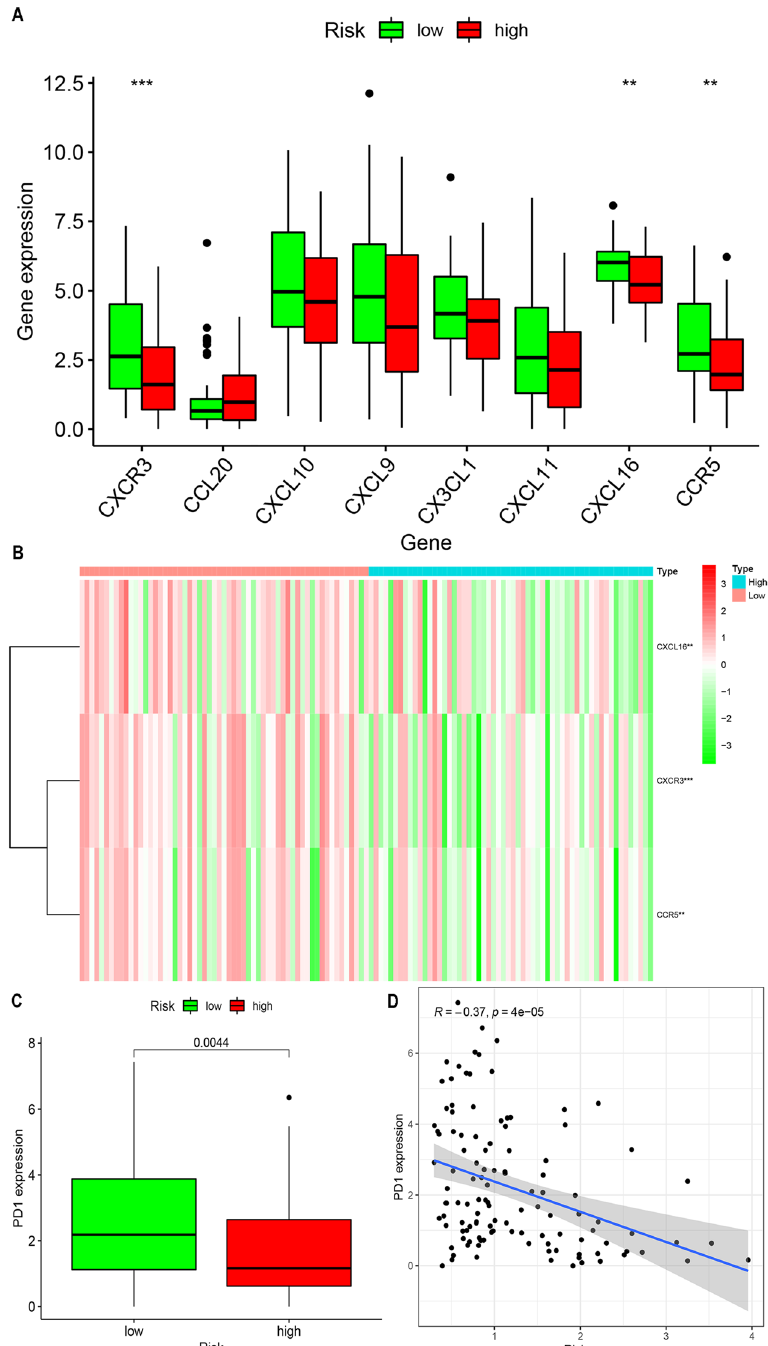
Figure 6. Differences in the expression of immune genes and PD1 between the high-risk group and the low-risk group. ( A , B ) The expression levels of CXCL16, CXCR3 and CCR5 are significantly different in the two groups of samples, and the expression levels are higher in the low expression group. ( C ) Box plot of PD1 expression levels in the high expression group and the low expression group. ( D ) Scatter plot of the correlation between PD1 and patient risk